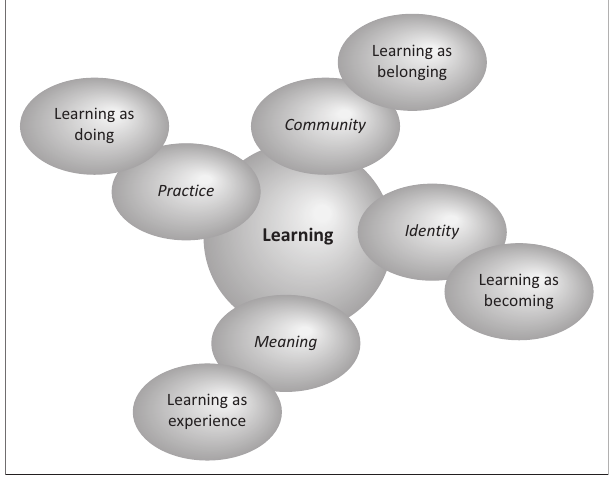
FIGURE 1: Wenger’s social theory of